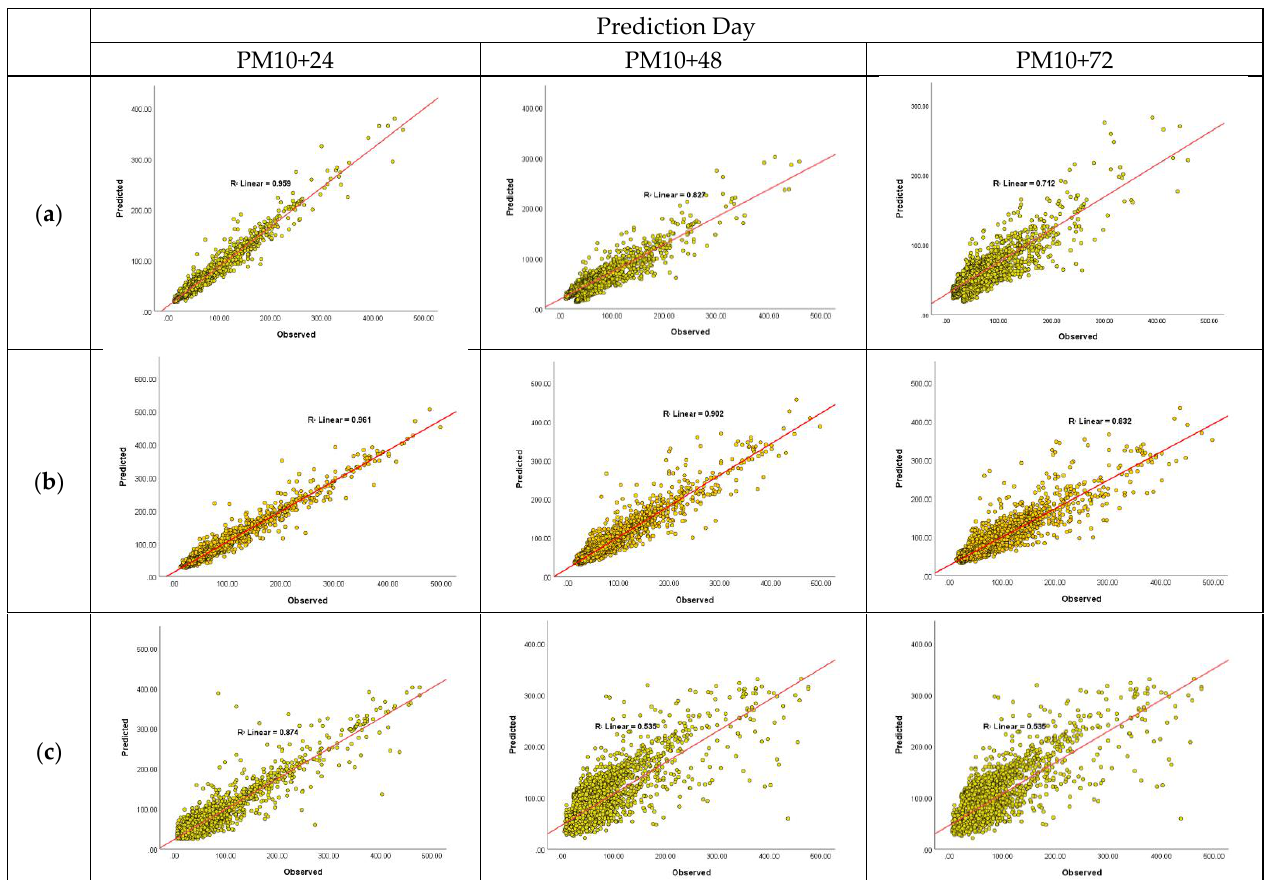
Figure 8. Relationship between observed and predicted value of PM10 concentration using the best predictive model ( a ) Pasir Gudang, ( b ) Melaka, ( c ) Petaling Jaya. predictive model ( a ) Pasir Gudang, ( b ) Melaka, ( c ) Petaling